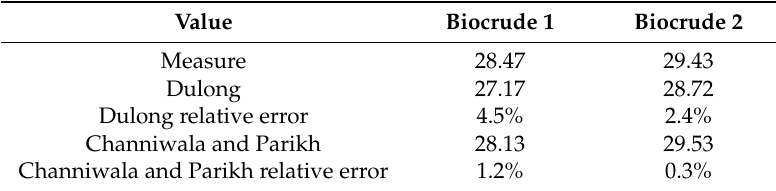
Table A5. Measured and evaluated HHV of BC1 and BC2 samples produced at 350 ◦ C-5 min-20% (Procedure 1) in MJ kg − 1 .